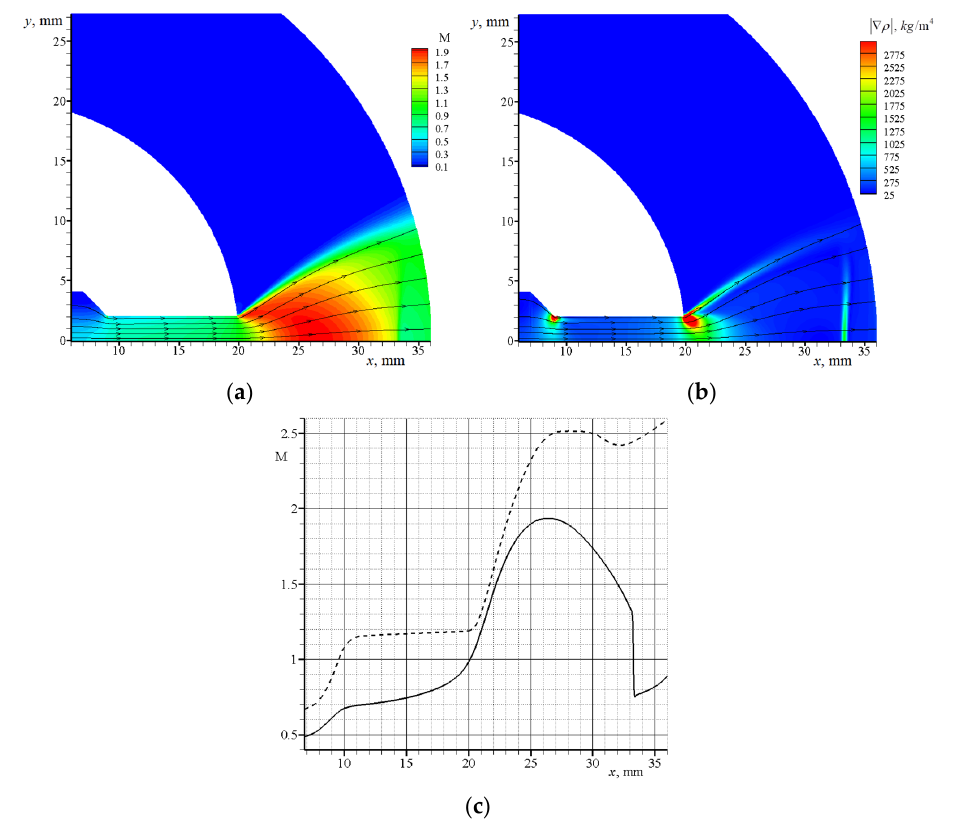
Figure 5. Steady-state gas flow in the channel in the case of h = 0.2 mm: ( a ) Mach-number isolines and gas streamlines; ( b ) isolines of density gradient |∇ ρ | ; ( c ) Mach-number profile on the axis y = 0; the dashed line shows data calculated without taking into account the friction force acting on the gas from the side of the disks.